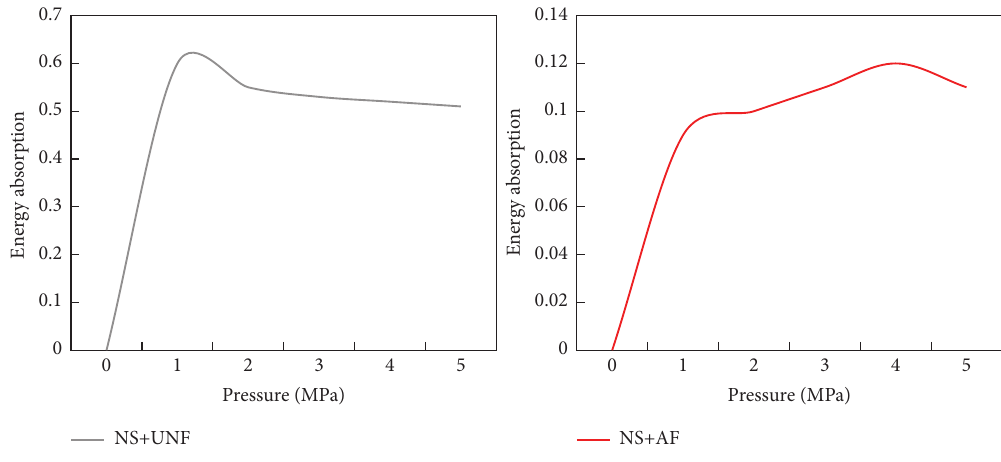
Figure 8: Buffer performance analysis.